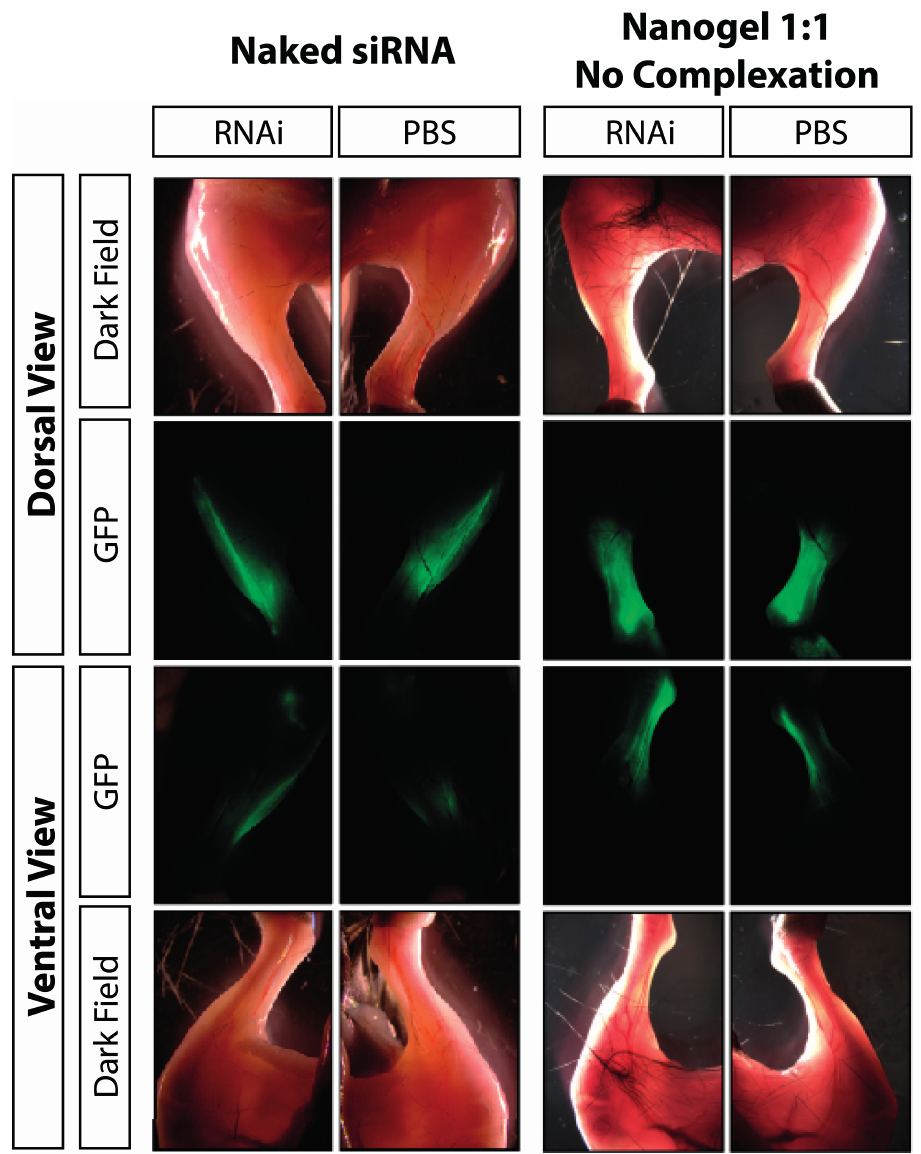
Figure 5. Evaluation of naked siRNA delivery and the requirement for nanogel complexation. Left panel: two μ g of 3’-methylated Gfp siRNA (without nanogel NSPs) were injected to hind limbs along with 2.2 × 10 8 PFU/site of Adex-GFP as indicated in each row. Contralateral limbs received Adex-GFP and were treated with PBS. Reductions in GFP expression were not observed (n = 6, p = 0.811). Right panel: RNAi treatment limbs were treated with neutral nanogel NSP (no siRNA complexation) (n = 7, p = 0.339). Results confirm the requirement of complexation of siRNA to facilitate delivery to